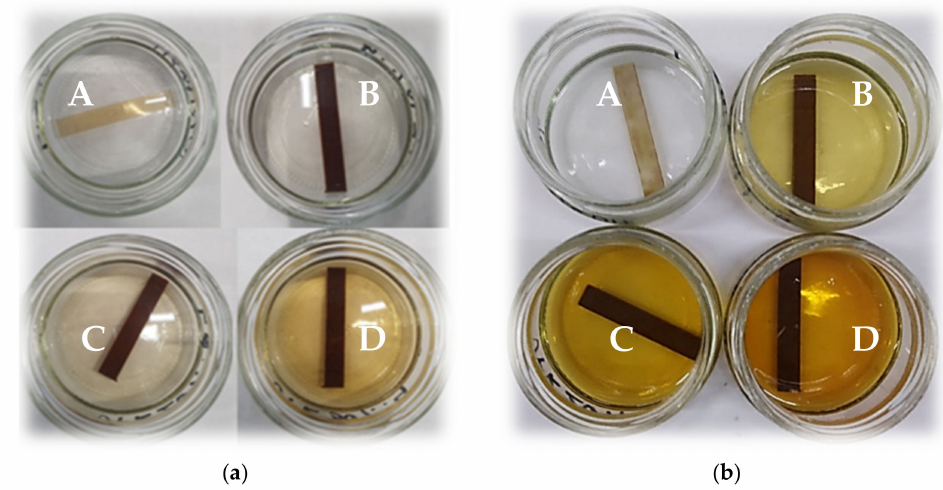
Figure 7. Images of the UPR/PSP composites during the immersion test. The color change of alkaline aqueous solution after: ( a ) 7 days; ( b ) 140 days. A—pure UPR; B—UPR + 10; C—UPR + 20; D—UPR +